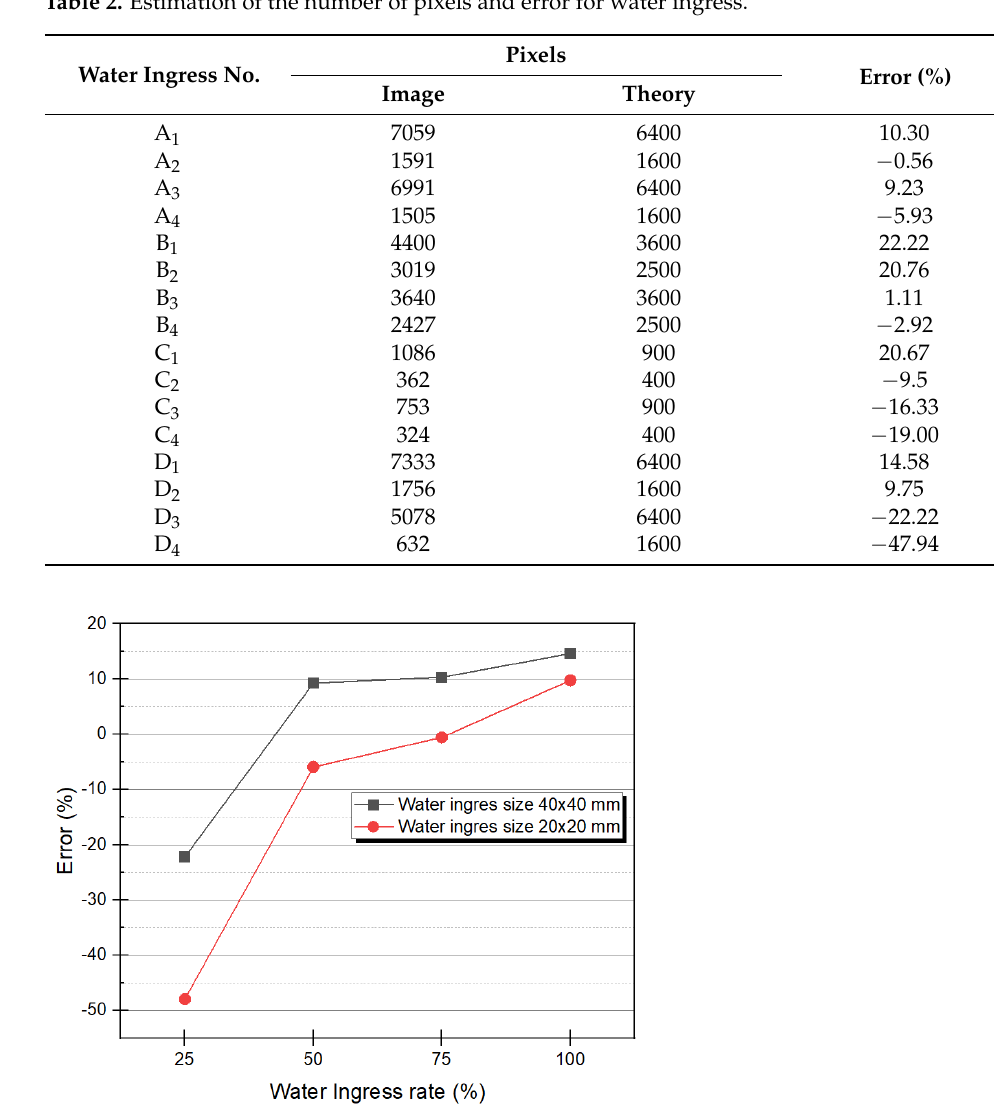
Figure 11. Error changes according to water ingress